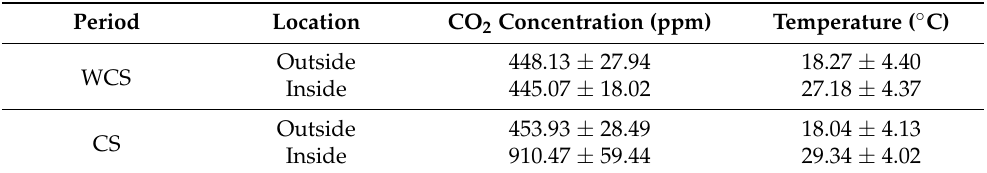
Table 2. Variations of CO 2 concentration and temperature inside the greenhouse and outside envi- ronment. Values represent the mean ± the standard deviation.